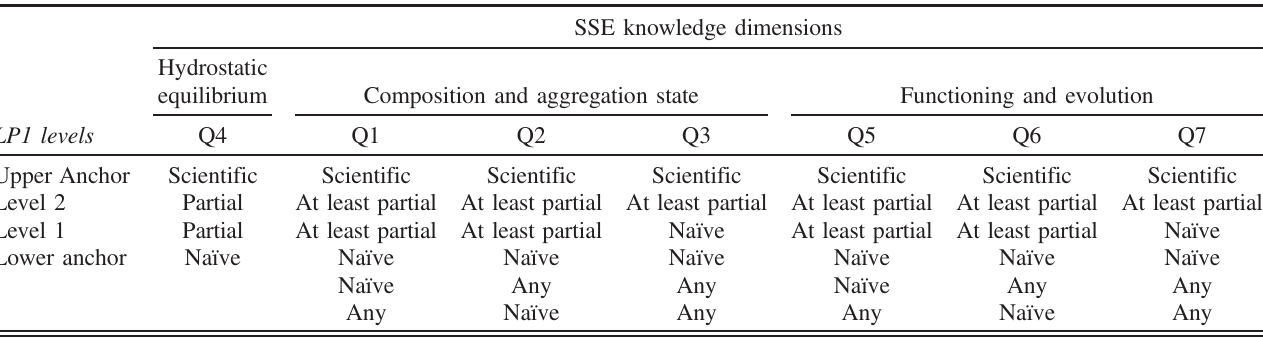
TABLE I. Correspondence between knowledge dimension of the LP about SSE and the interview questions. Level mapping for LP1 is also reported (see Section III. E. for details). The complete mapping is reported in Supplemental Material I